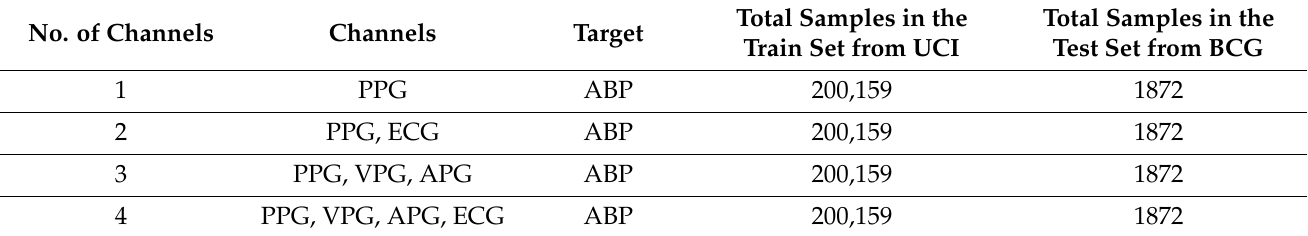
Table 3. Description of training and testing sets for Experiment 2 (Method 1).